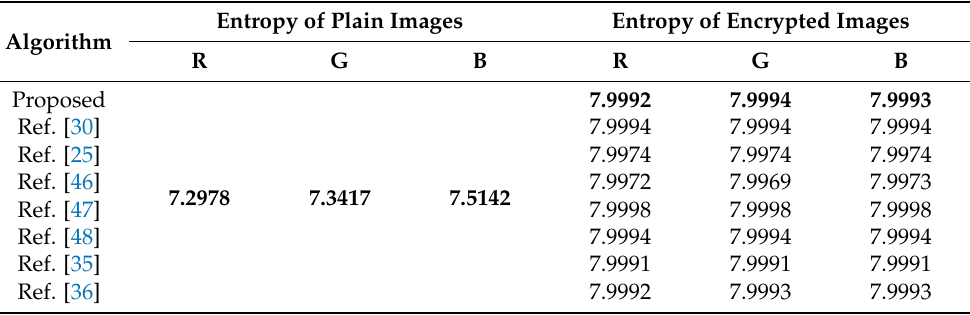
Table 13. Comparison of information entropy with other algorithms (The bold part is the relevant values of the proposed algorithm.).